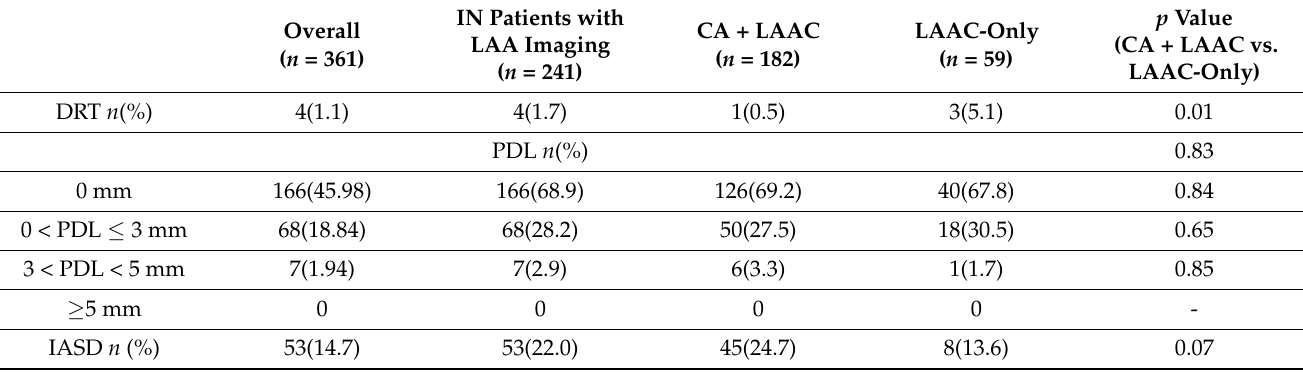
Table 3. TEE at 3-month